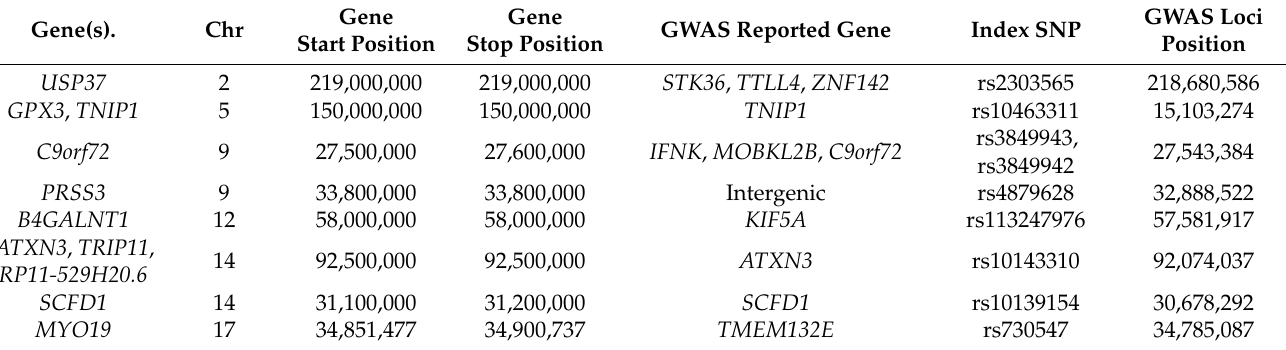
Table 2. Independent TWAS genes mapped to GWAS loci reported by GWAS catalog.